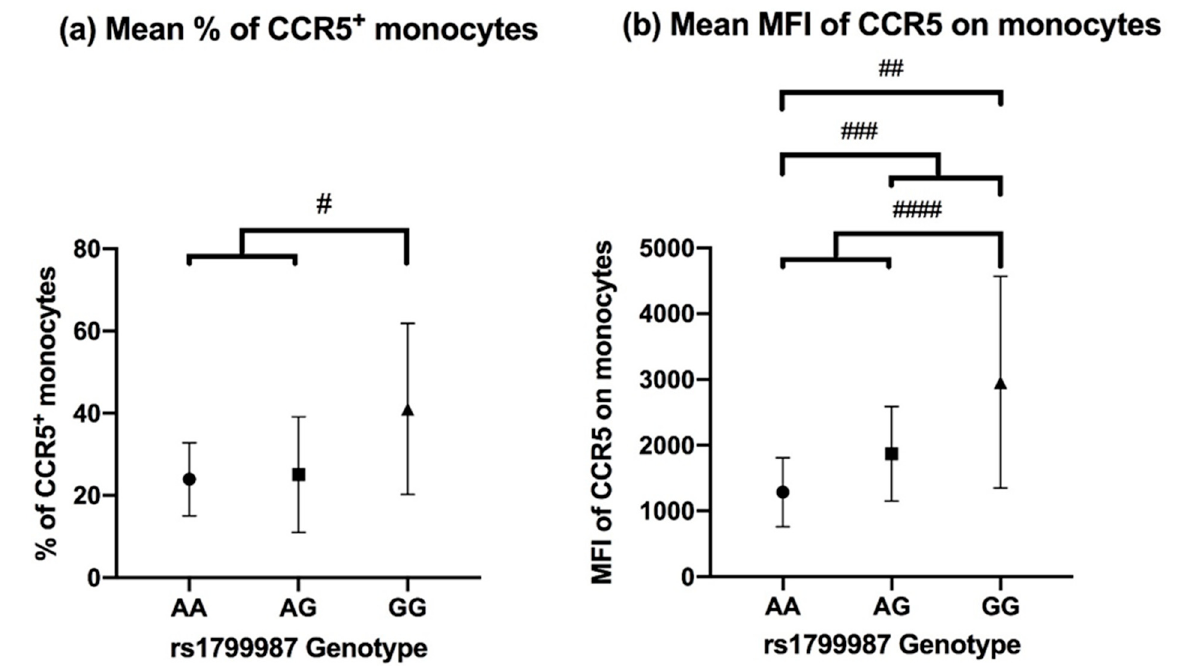
Figure 2. ( a ) Mean % of CCR5 positive (CCR5 + ) monocytes in 21 patients with the different genotypes for SNP rs1799987. Each patient was analyzed once. Comparison of AA vs. AG vs. GG ( p = 0.094) was not significant, but comparison of GG vs. AA + AG showed a significant difference ( p = 0.028) # . ( b ) Mean MFI of CCR5 on monocytes in 21 patients with the different genotypes for rs1799987. Comparing AA vs. GG ( p = 0.026) ## , AA vs. AG + GG ( p = 0.038) ### , AA + AG vs. GG ( p = 0.012) #### .